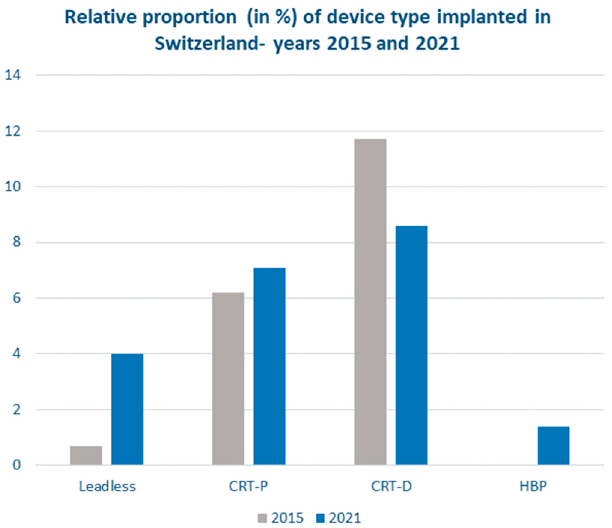
Figure 1. Relative proportion of CIEDs with pacing function implanted in Switzerland in 2015 (grey bars) and 2021 (blue bars). The proportions were calculated based on the total number of implanted devices with pacing function in 2015 ( n = 6381) and 2021 ( n = 8015), respectively. Currently, the miniaturized leadless transcatheter pacing system is available both as a single-chamber pacing device (VVI(R) modality) [9] and a single-chamber device with atrial- sensing capability through accelerometer-based atrial detection (VDD modality) [10]. These systems significantly reduce peri-procedural complications, have a good long-term perfor- mance, and only rarely cause endovascular infection [7,9]. However, there are some con- cerns about procedural vascular access complications because of the bulky transvenous fem- oral sheath [11] and about approaches to device change and extractability [12]. As far as cardiac resynchronization therapy is concerned, changing trends in the im- plantation of CRT devices must be considered in the wider context of overall heart failure patient management improvements and specific developments in the field of device ther- apy. Early diagnosis, preventive strategies, and the recent adjunct of angiotensin receptor- neprilysin inhibitor and sodium-glucose cotransporter 2 inhibitors for the medical optimi- zation of heart failure treatment [13], may potentially reduce the need for CRT. Although current trends in CRT device implantation remain relatively steady, reductions in CRT-D implantation have been observed (Figure 1). Non-device-associated improvements in heart failure management, the low rate of ventricular arrhythmic events in patients with non-is- chemic heart disease [14], the lack of an accurate standardized approach for stratifying SCD in these patients [15,16], and long-term ICD-related morbidity, especially in the elderly pa- tients, are all aspects that favour CRT-P over CRT-D. More recently, in selected patients, selective LBB pacing was found to be feasible and may correct and revert LBBB in selected patients [17], including heart failure patients with LBBB, and may represent a novel ap- proach to deliver effective CRT [18]. However, the lack of data on the evolution of electrical parameters over time and on the extractability of these leads, that are fixed deeply into the interventricular septum, remain important concerns that hamper the diffusion of CSP [19]. There is a need for long-term multicentre data in the field of CSP. An important area of development to address CIED-related morbidity is the clinical practice of transvenous lead extraction (TLE). The large prospective European registry